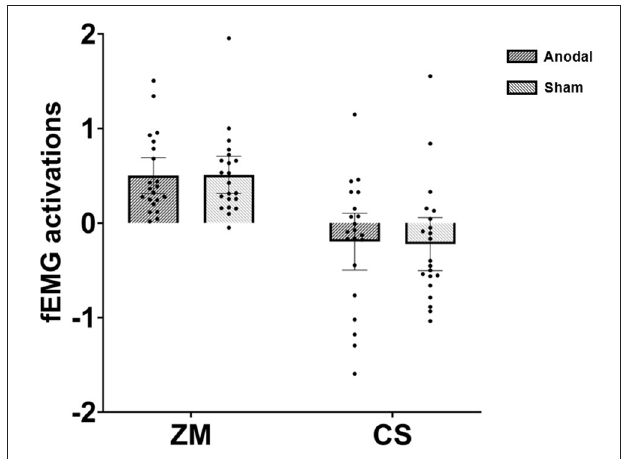
FIGURE 1 | Facial electromyography (fEMG) [ zygomaticus major (ZM) and corrugator supercilii (CS)] activations under various conditions in Experiment 1; dots refer to individual datapoints.